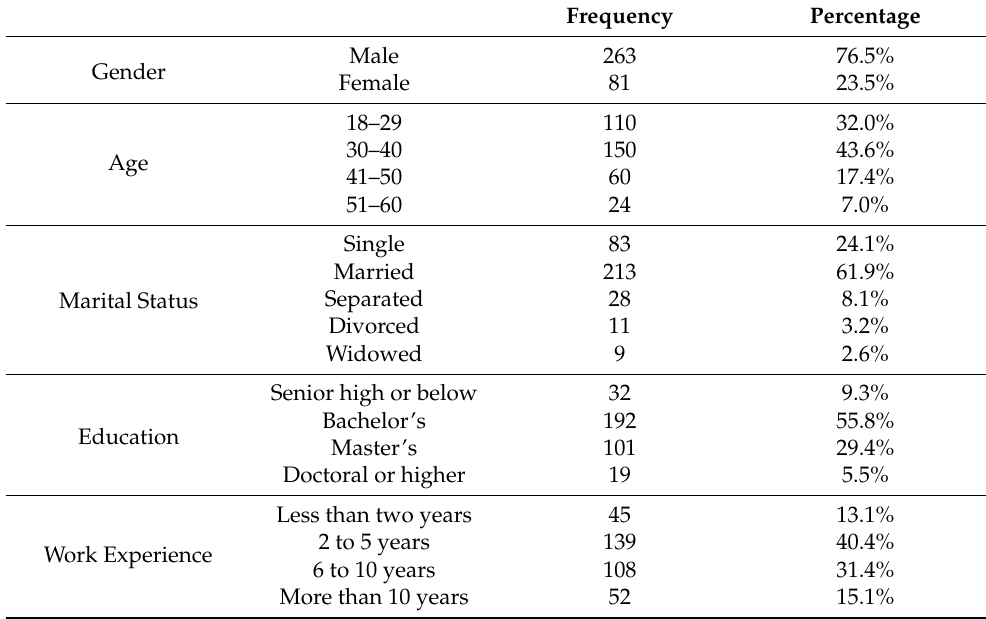
Table 1. Demographic Details of